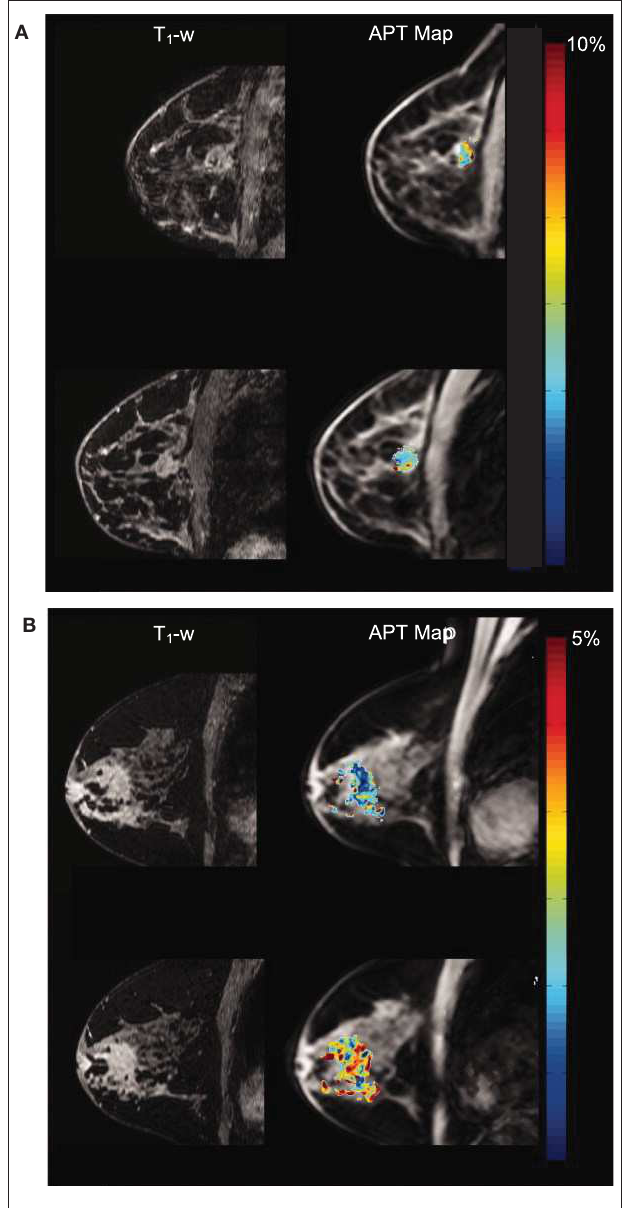
FIGURE 5 | Amide proton transfer maps overlaying anatomical T 1 -weighted images acquired at 3T. The top row shows data acquired prior to neoadjuvant chemotherapy (NAC); the bottom row shows data acquired after one cycle of NAC. (A) Patient who had complete response (i.e., no residual tumor) and (B) patient who had progressive disease. Reprinted with permission from Chan et al. (95); © 2012 Wiley Periodicals, Inc.